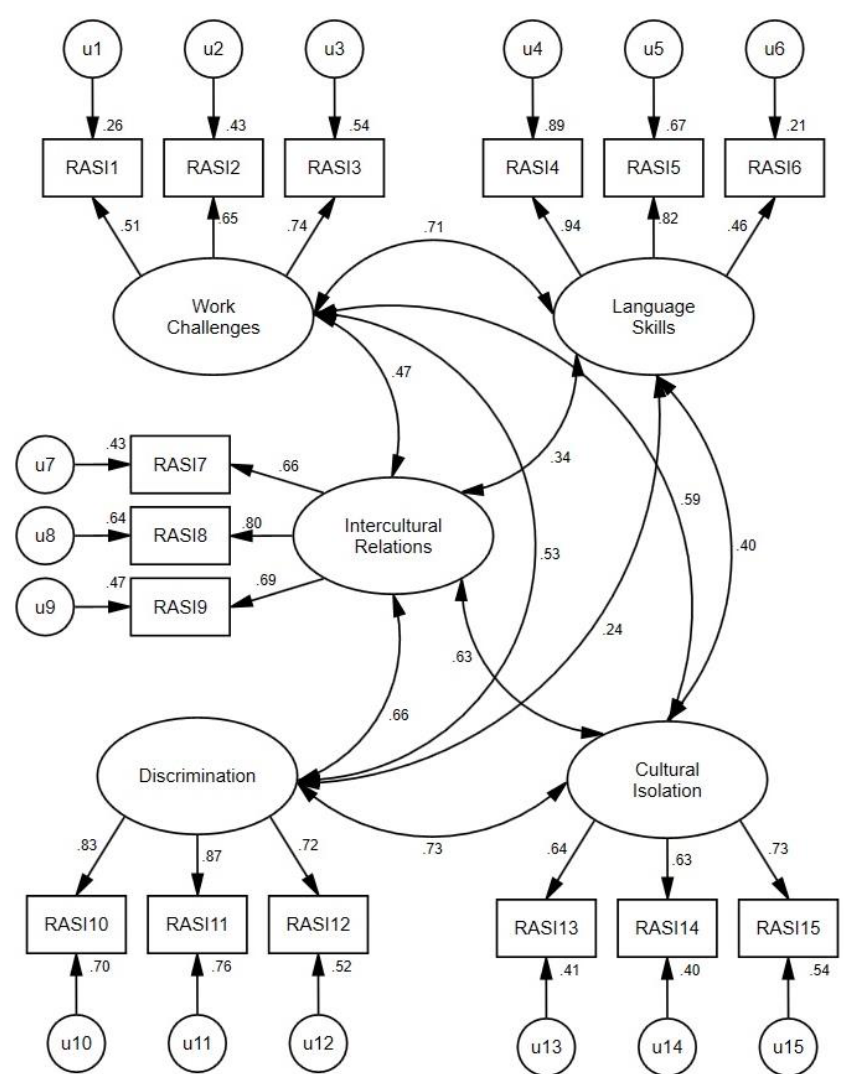
Figure 1. 5-factor CFA for the 15-item Riverside Acculturation Stress Inventory in Spanish. Note: All item loadings are standardized loadings.